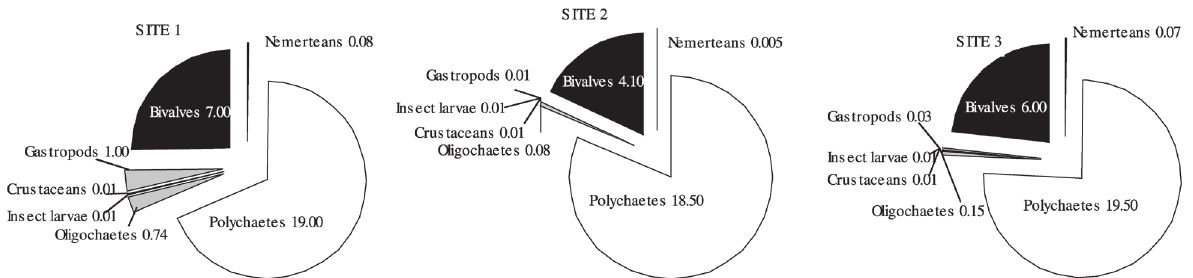
Fig . 8. – Comparison of benthic invertebrate macrofauna in summer (----) and winter ( ____ ) at the three sampled sites, during 1994-1996, at Culbin Sands lagoon, NE Scotland (test: DECORANA, only values along the two main eigenvalues were plotted).